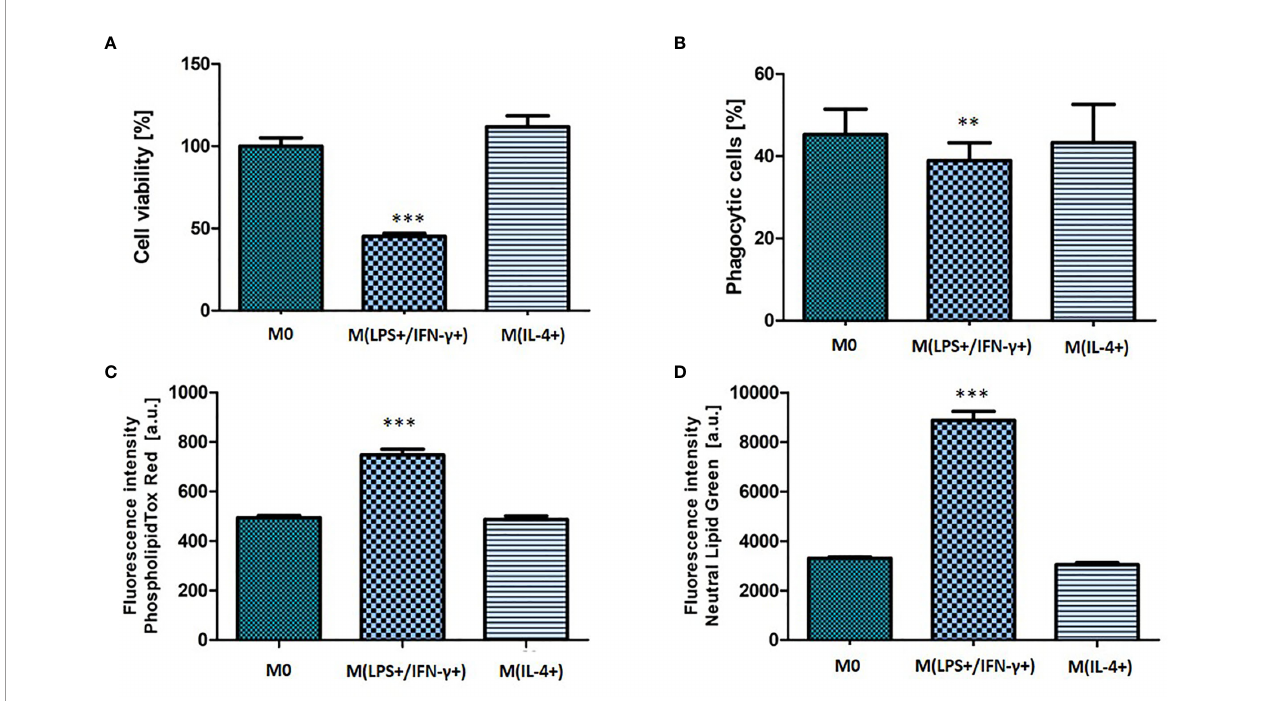
FIGURE 3 | Functional characteristic of non-activated, M(LPS+/IFN- g +) or M(IL-4+) activated NR8383 rat macrophages. Cell count (A) , phagocytic activity (B) , cellular phospholipid (C) and cellular neutral lipid content (D) were quanti fi ed in non-activated macrophages (M0), activated with 100 ng/ml LPS and 20 ng/ml IFN- g [M(LPS+/IFN- g +)] or activated with 30 ng/ml IL-4 [M(IL-4+)]. Data are normalized to cell count and presented as mean values ± SEM of three separate experiments. Statistical comparisons are made using a one-way ANOVA analysis with Bonferroni ’ s multiple comparison post-hoc test. Results are compared to non-polarized control (M0); ** indicate p < 0.01, *** indicate p < 0.001.